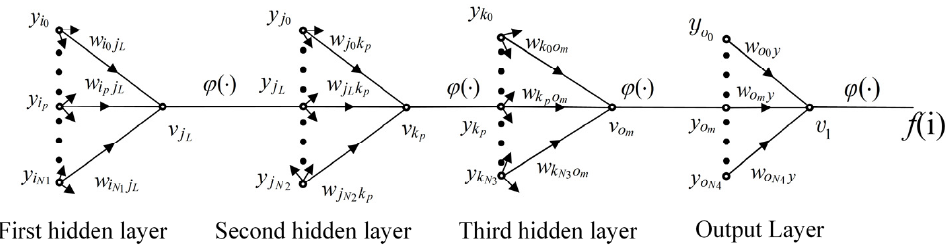
Figure 5. Neural network equivalent model.